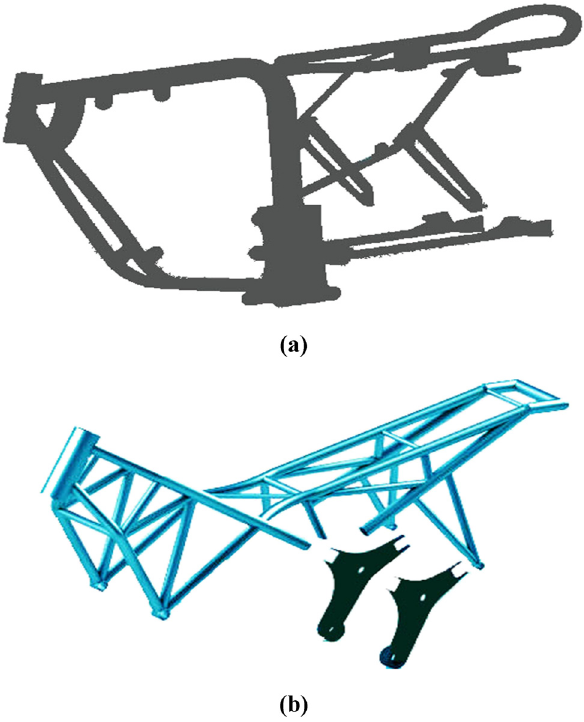
Figure 3: ( a ) Prototypical design of the system and ( b ) chassis model